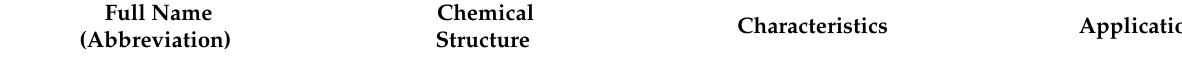
Table 4. Summary of the chemical units of polymer-based photoluminescence probes a .